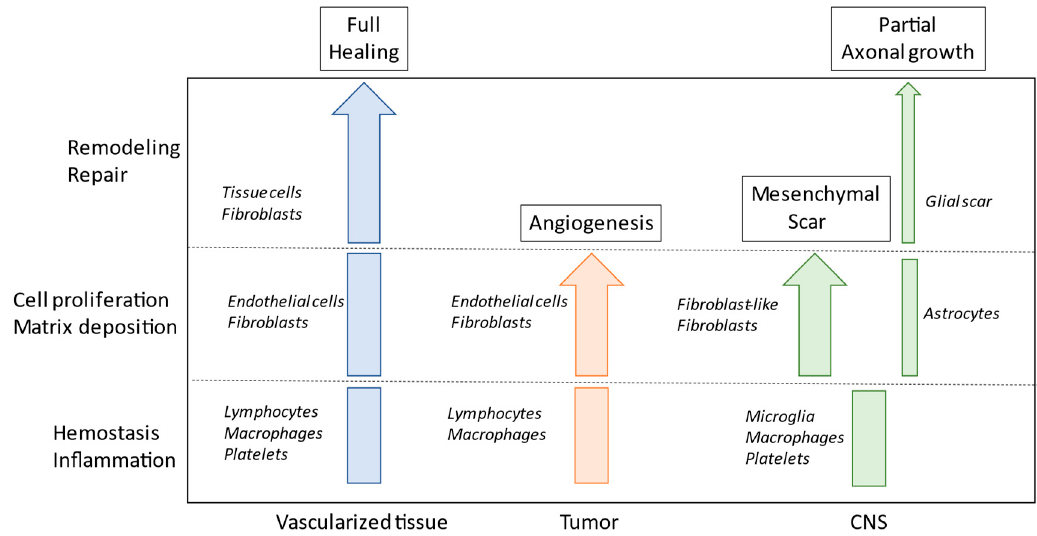
Figure 2. Schematic view of the process of healing in vascularized tissue, in tumors, and in central nervous system (CNS) injuries. Different cell populations are involved in the different steps.